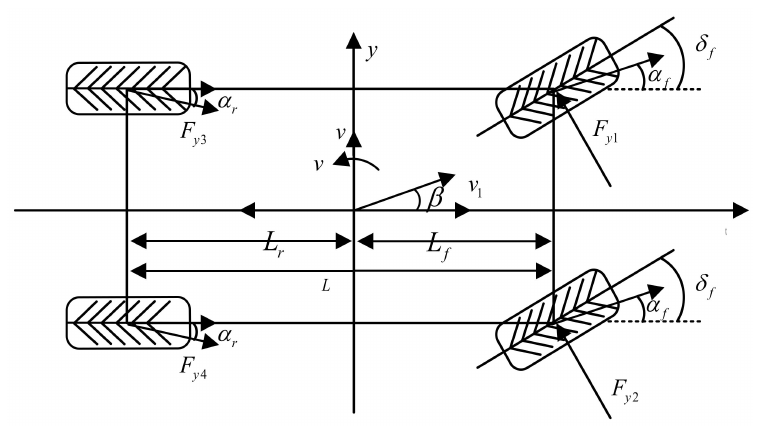
Figure 1. Planar dynamic pattern of